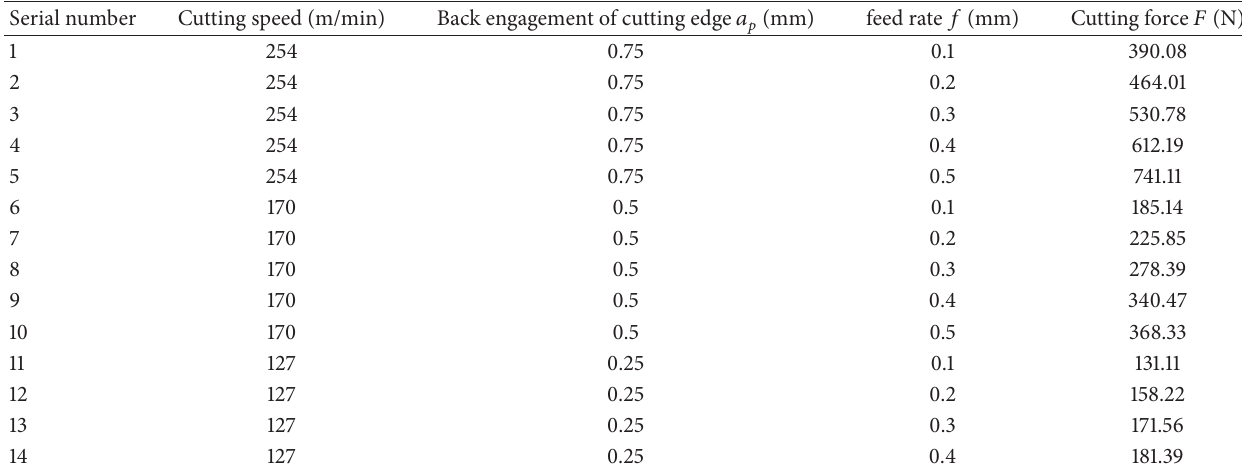
Table 3: The main cutting force measurement of AISI-1045